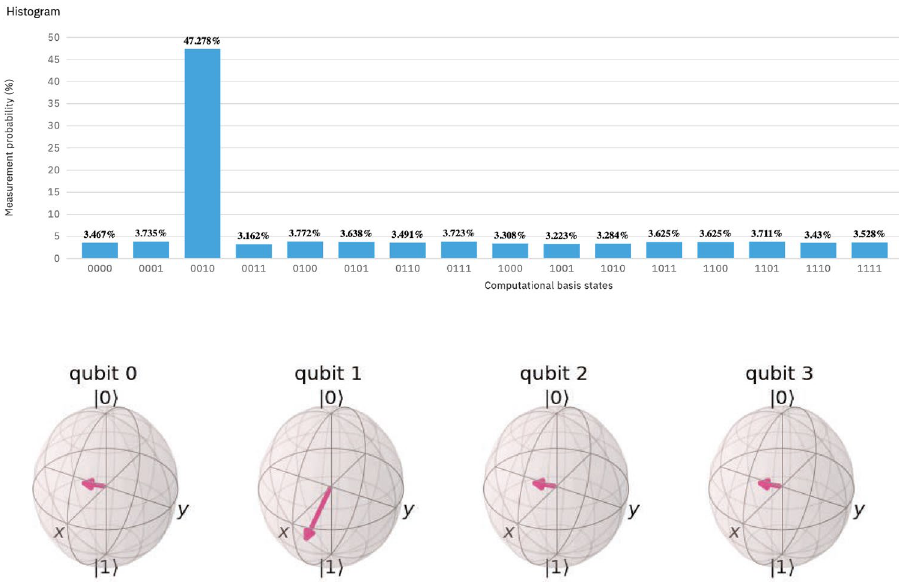
Figure 2. Four-qubit quantum search and qubit representation. The algorithm yielded a distinct peak in probability of target state measurement (left) when run on four qubits. The probability distribution is an approximation of the state-vector-defined probability distribution via sampling, with 8192 samples, and therefore has a negligible K–L divergence ( 1.15 × 10 − 3 ) from the known distribution. The final multi-qubit state that is conducive for a successful search is shown in Bloch Sphere representations of each qubit